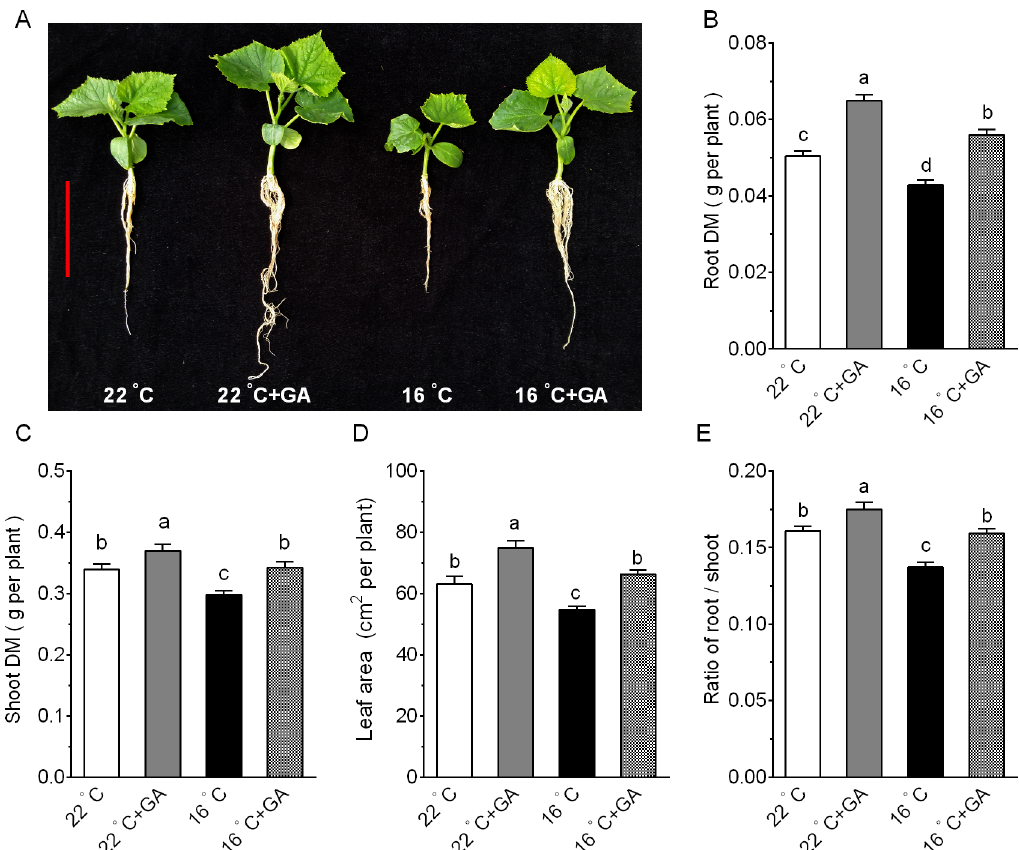
Fig 1. Effect of suboptimal T r and GA on the growth of cucumber seedlings. (A) Phenotypes of cucumber seedlings. (B) Root dry mass (DM) of cucumber seedlings. (C) Shoot DM of cucumber seedlings. (D) Leaf area of cucumber seedlings. (E) Root to shoot ratio of cucumber seedlings. 15-day-old cucumber seedlings were transferred to 22°C T r and 16°C T r conditions in the presence or absence of GA 5 μ M GA for 8d. Data are means ± SE. Different letters on the top of column indicate significant differences ( P < 0 . 05 , n = 6). Bar = 10